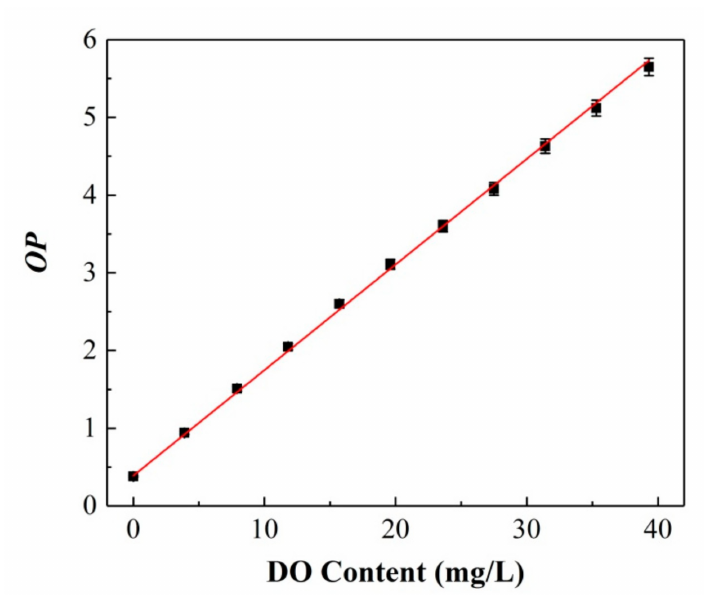
Figure 4. Calibration curve between the optimal parameter ( OP ) value and DO content of the ratiometric sensing